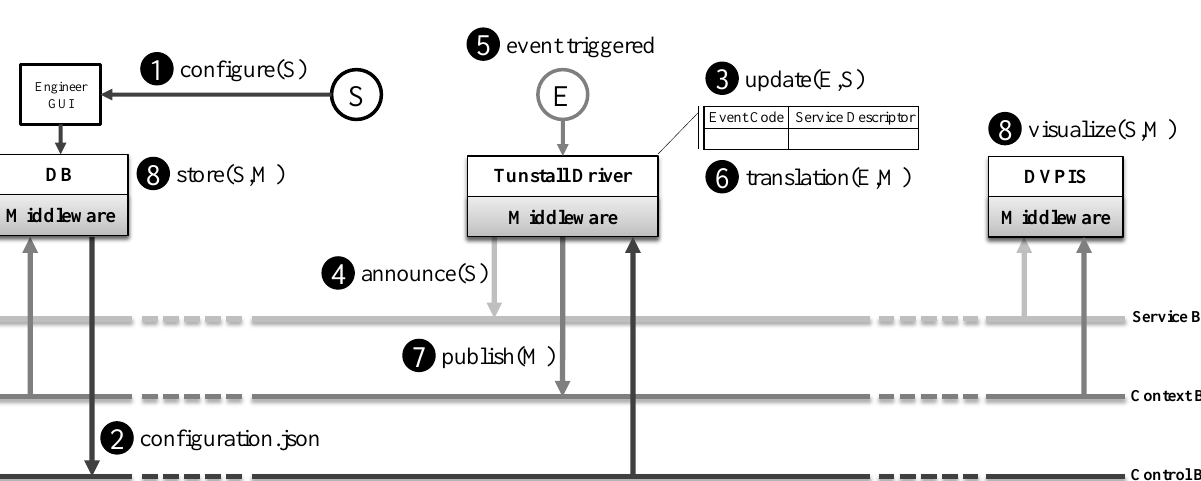
Figure 10. The sensor integration